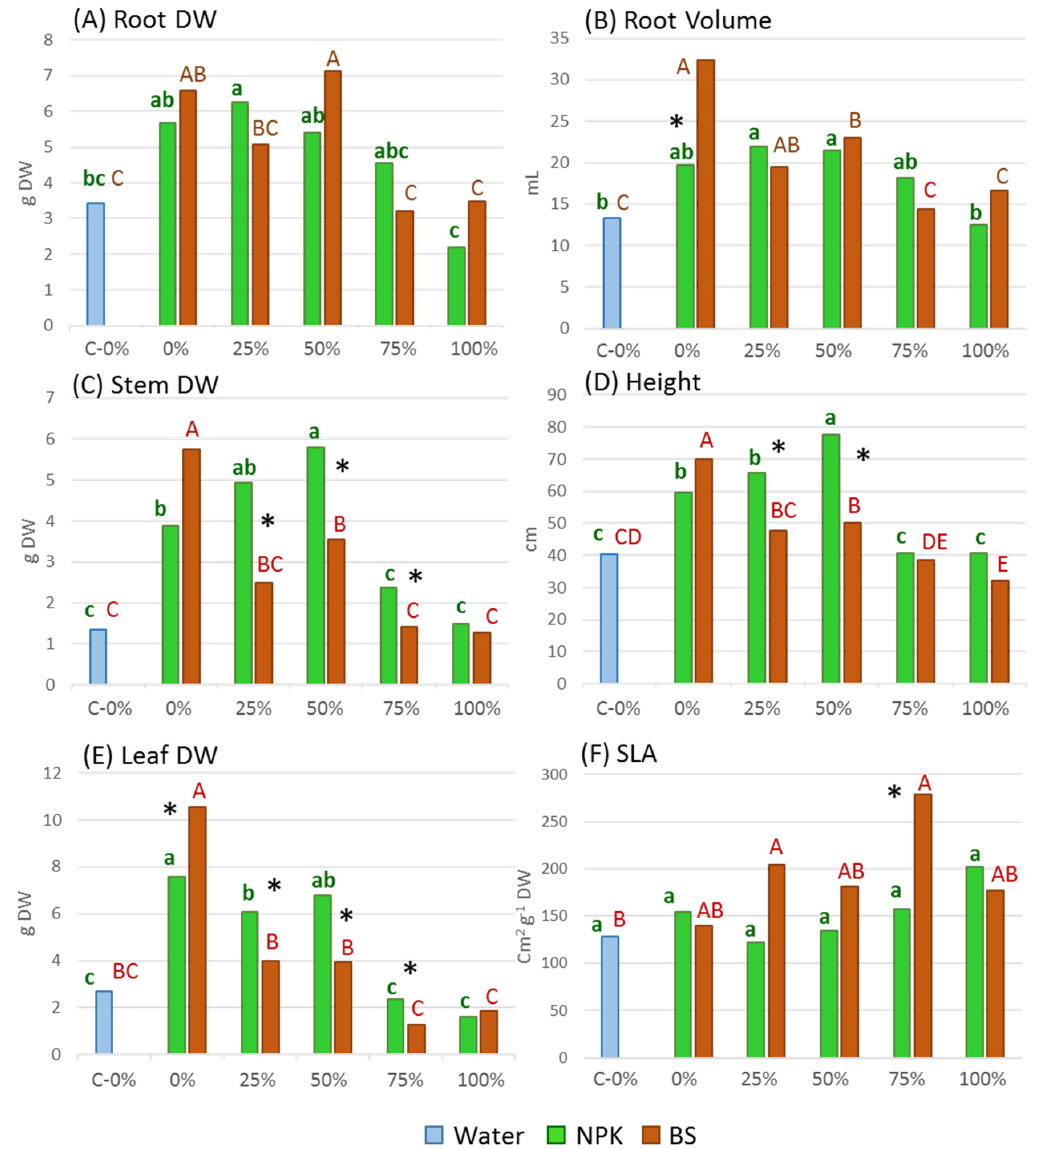
Figure 2. Biometric parameters (( A ) Root DW, ( B ) Root Volume, ( C ) Stem DW, ( D ) Height, ( E ) Leaf DW, ( F ) SLA) of chestnut seedlings cultivated with the different substrate mixtures (compost: 0%, 25%, 50%, 75% and 100%) supplied with NPK (green bars) or BS (brown bars). Blue bars represent control substrate 0% supplied only with water. SLA, specific leaf area. Different letters indicate significant differences ( p < 0.05; n = 6) between each substrate mixture (green lowercase letters for NPK and brown uppercase letters for BS). Asterisk means significant differences using t -tests between NPK and BS within each substrate mixture.